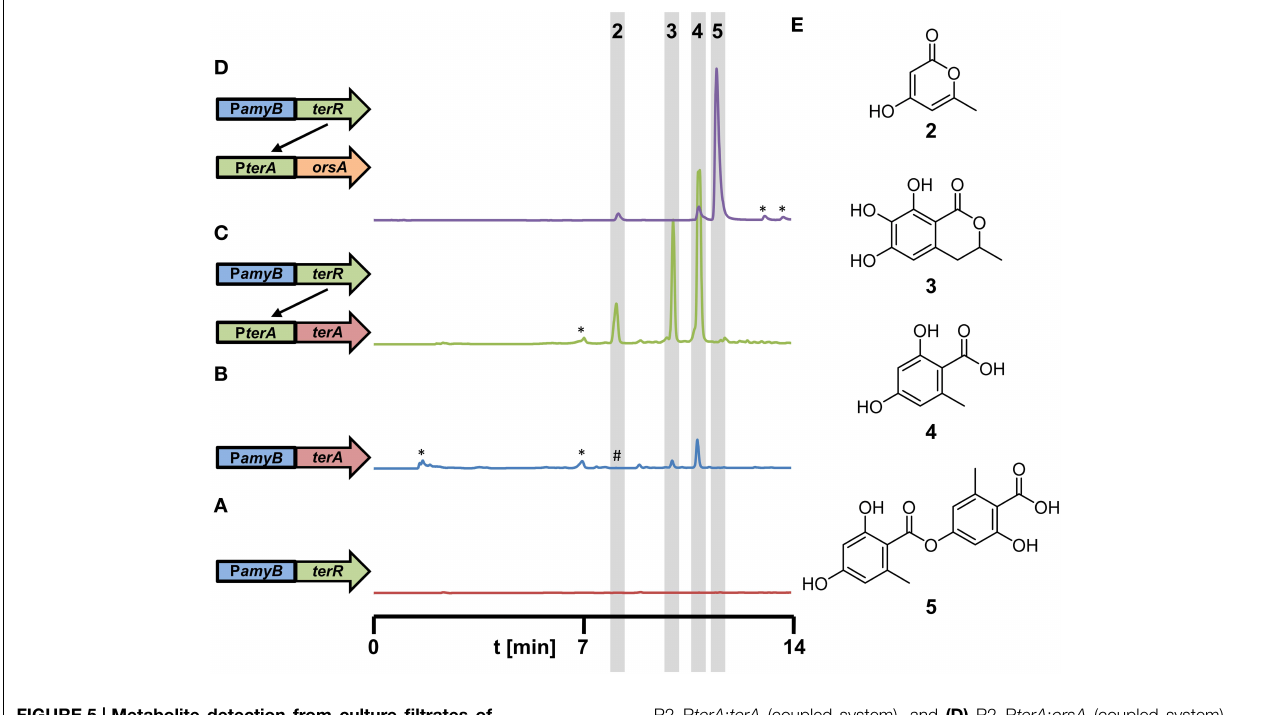
FIGURE 5 | Metabolite detection from culture filtrates of recombinant A. niger strains expressing different polyketide synthases under control of the terR /P terA expression system. All strains were grown for 48h in AMM-G100 medium with 20mM glutamine as nitrogen source. (A–D) HPLC profiles from (A) A1144_P amyB : terR (P2, parental control strain), (B) A1144_P amyB : ter A (control strain)